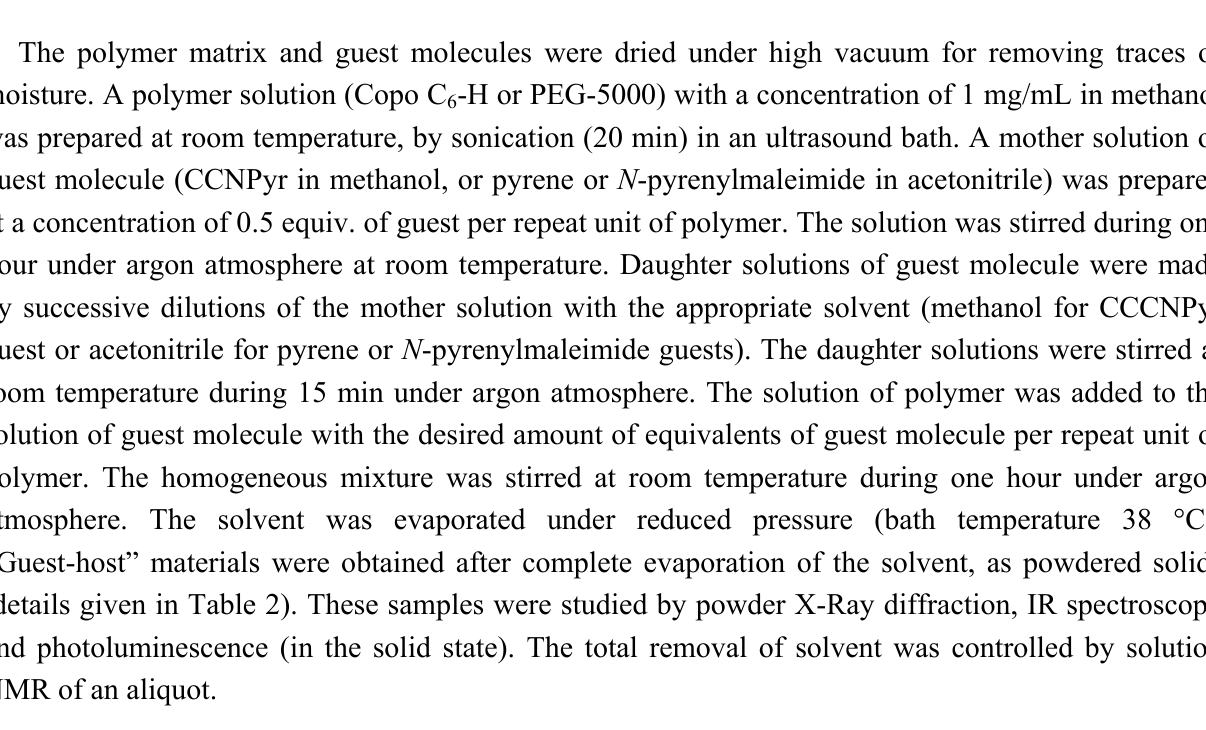
Table 2. Mass of guest for each “host-guest” material and corresponding